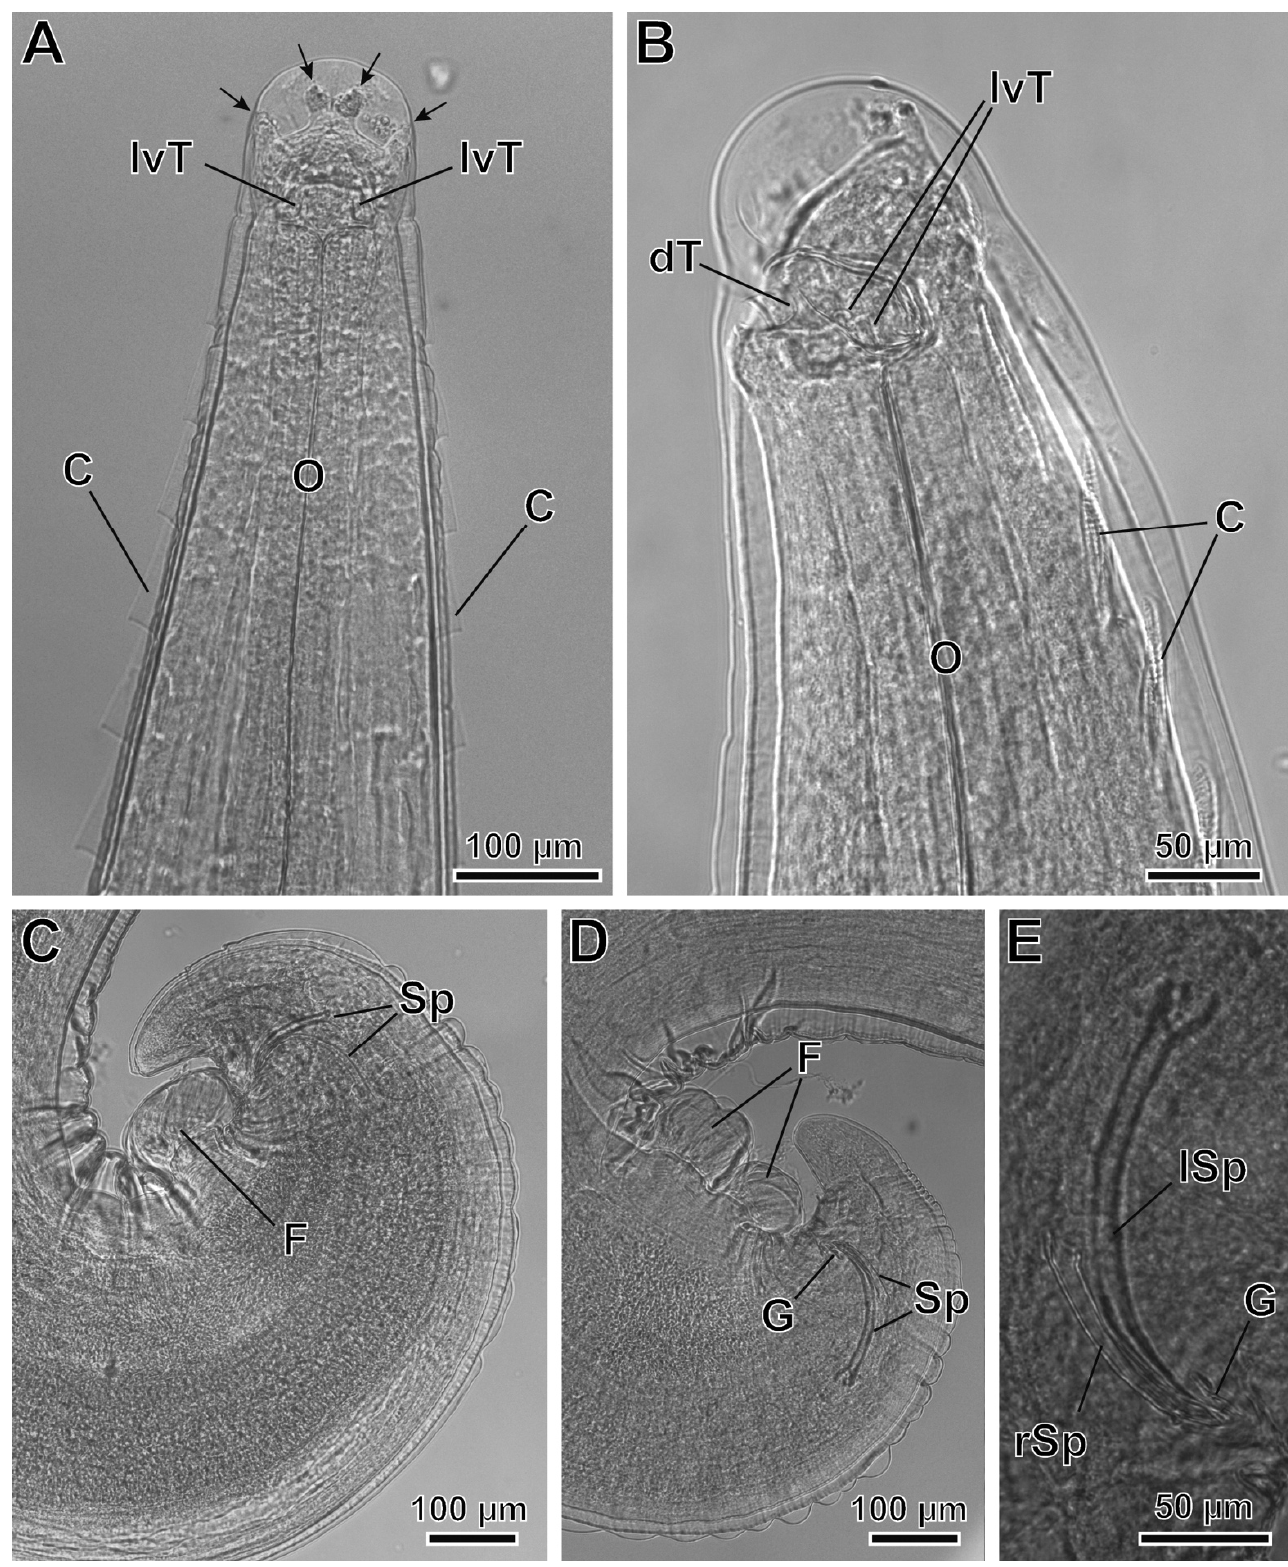
Figure 3. Pterygodermatites ( Pterygodermatites ) plagiostoma male, light microscopy. ( A ) Cephalic extremity, dorsal view showing the two lateroventral esophageal teeth (lvT) and four internal labial papillae (arrows). ( B ) Cephalic extremity, lateral view showing dorsal (dT) and lateroventral (lvT) esophageal teeth. ( C ) Caudal extremity of a male with one midventral fan (F). ( D ) Caudal extremity of a male with two midventral fans. ( E ) Detail of the right spicule (rSp), left spicule (lSp), and gubernaculum (G). (C) Cuticular combs; (O) esophagus; (Sp) spicules.